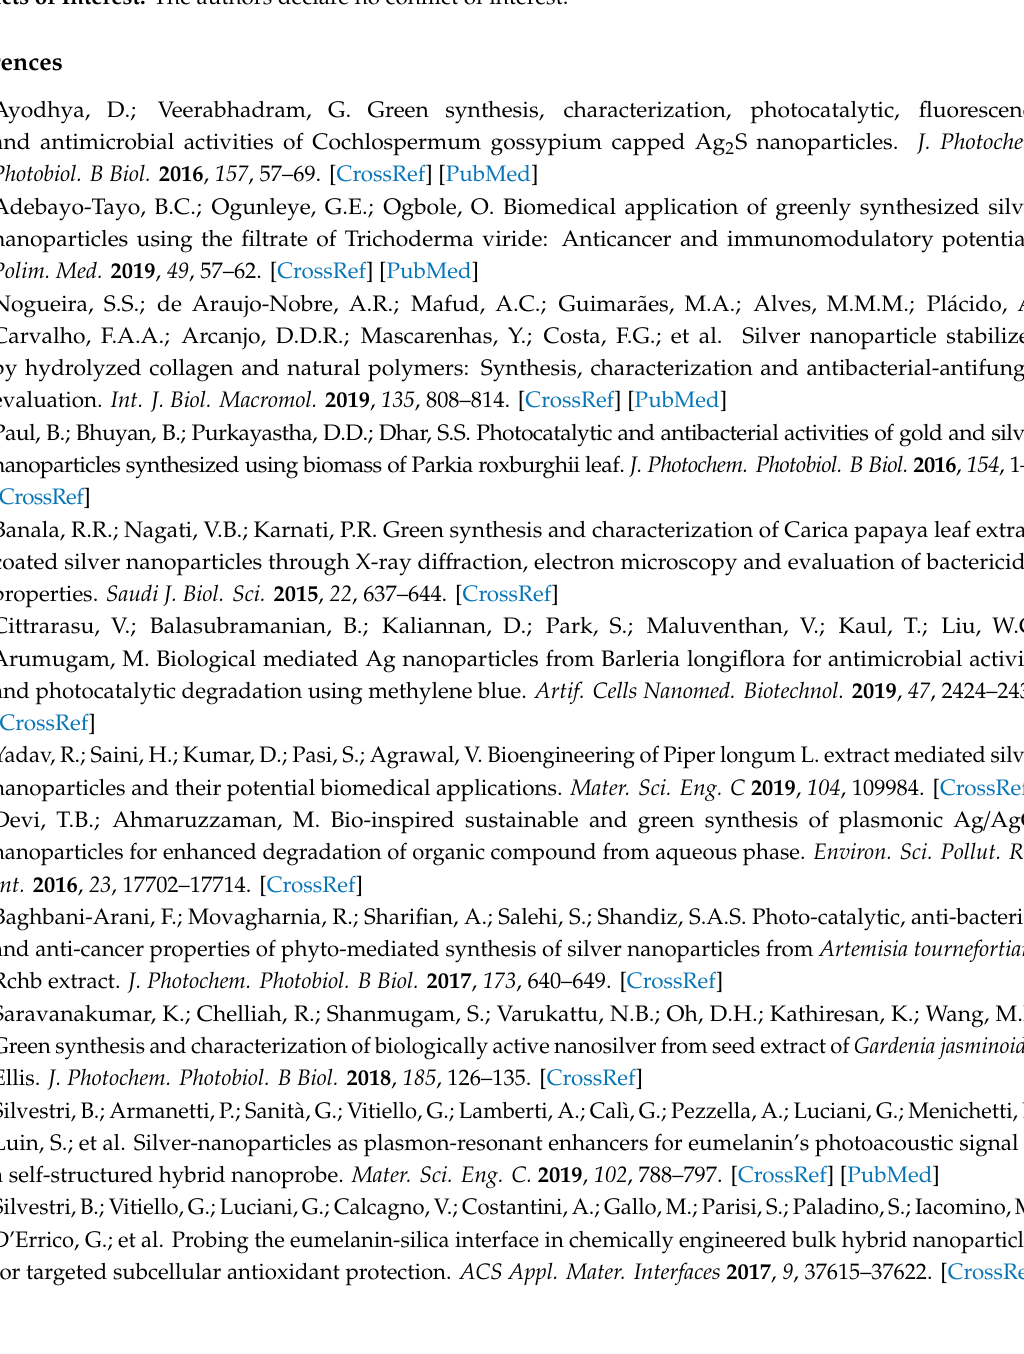
Figure S1: UV-visible spectrum of (A) MB, (B) MO, (C) RB, and (D) RB5 on addition of CTR, CTS, CTL, and